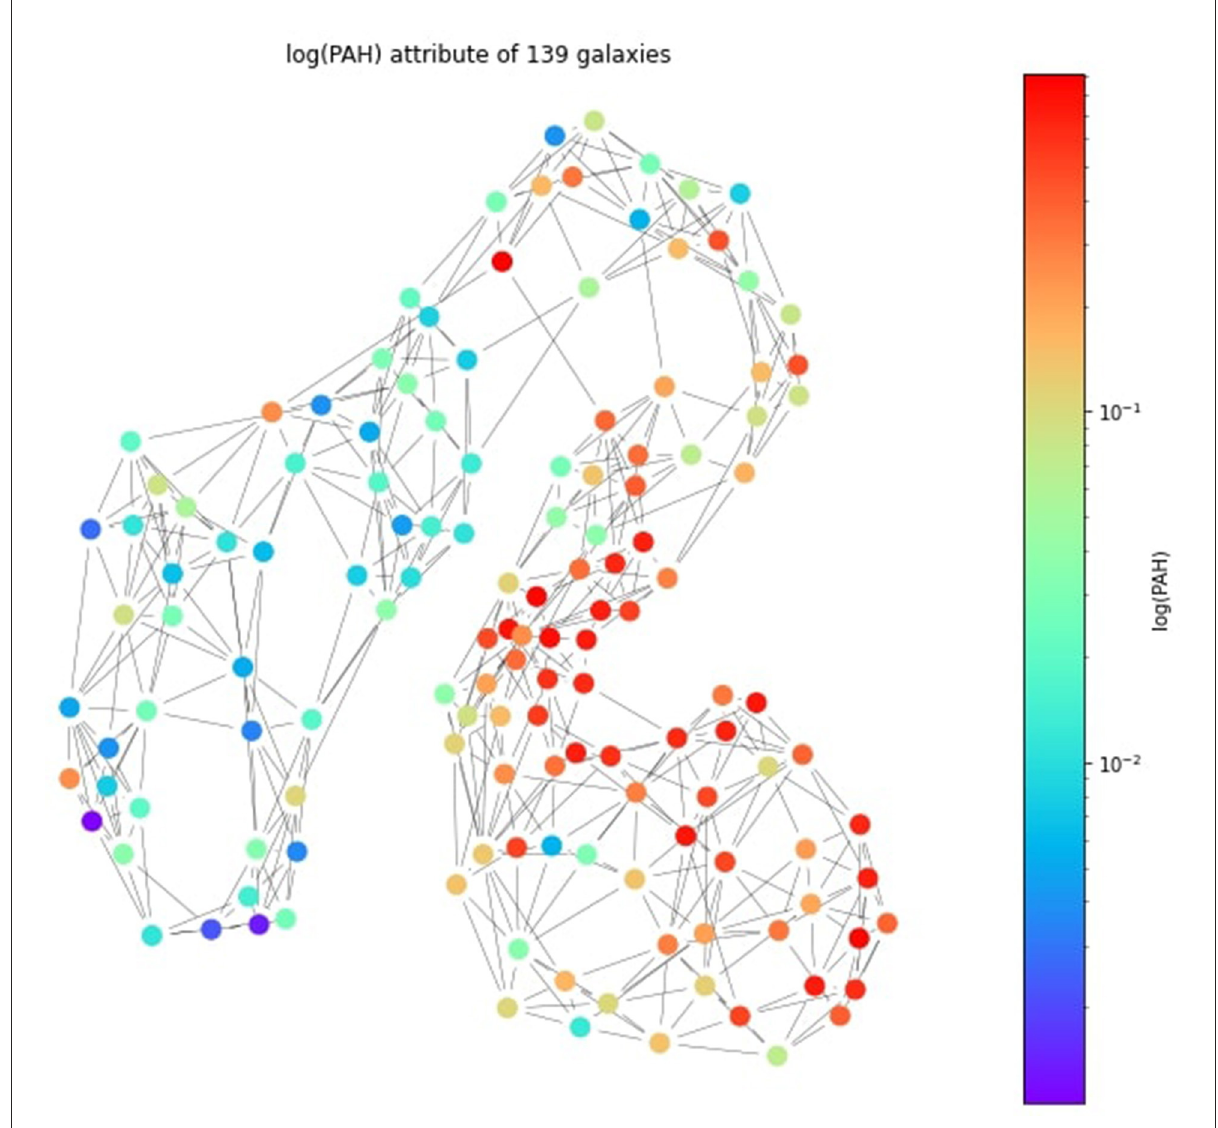
FIGUREA1 The PAH feature distribution on the